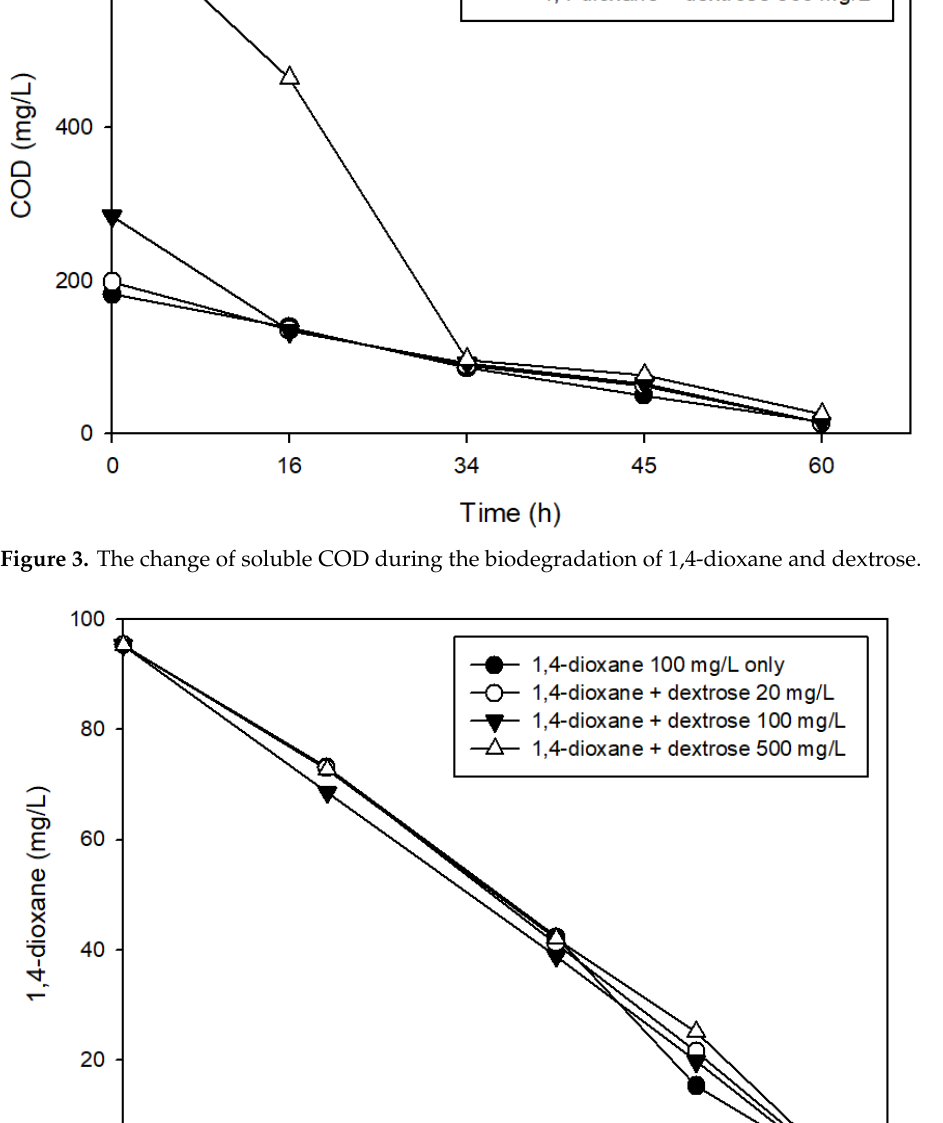
Figure 5. Cell growth of the mixed culture with different combinations of 1,4-dioxane and dextrose monitered by OD 600 .